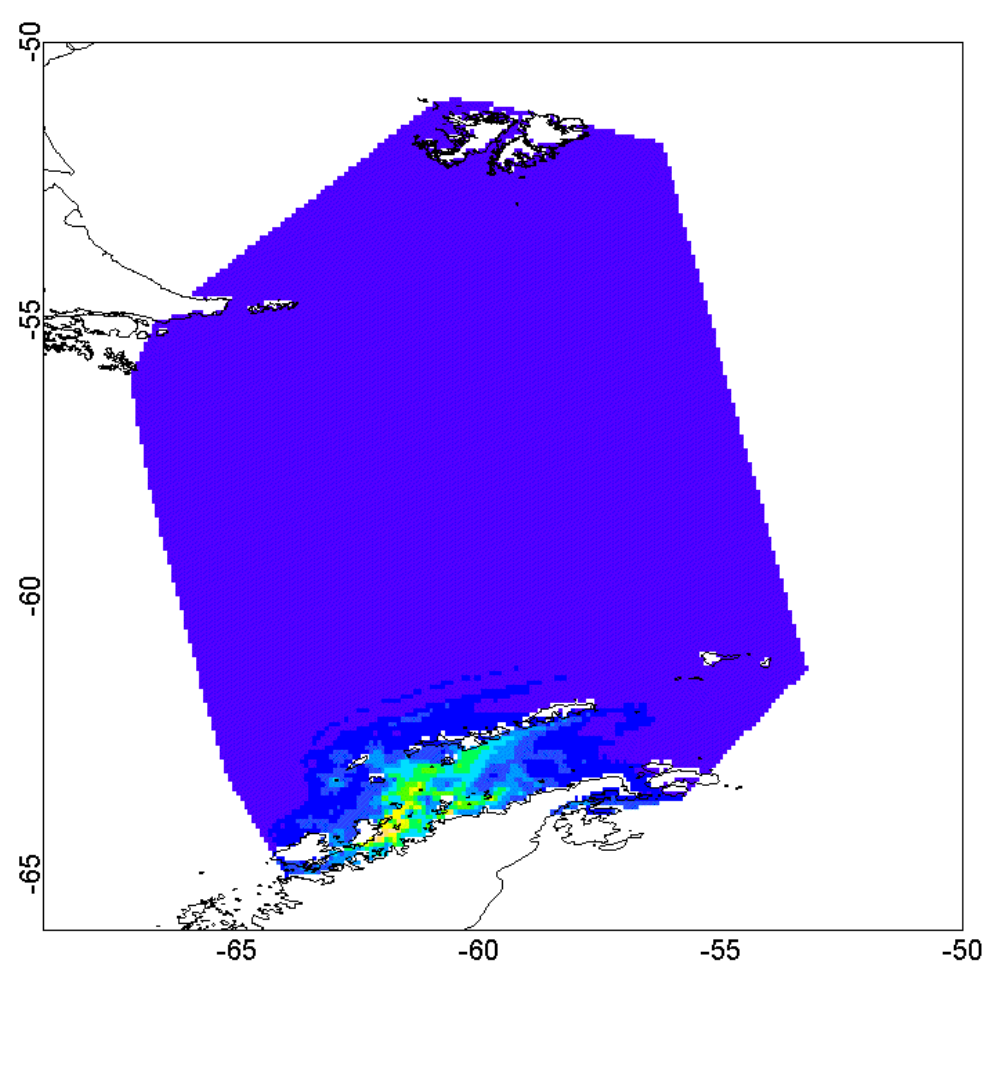
Fig. 3. An animation showing variation in predicted density of humpback whales. Each frame of the animation reflects an iteration of jackknife resampling: the removal of one trip’s effort and sightings data; refitting the detection function on the remaining sightings; reevaluating size-bias corrected estimates of mean school size; refitting the spatial model; and prediction across the grid. White patches within the regions of high density reflect grid squares predicted to have >0.22 humpback whale schools/nm 2 . The longest axis of the prediction grid (from the southern tip of South America to the northern tip of the Antarctic Peninsula) is approximately 500 nm long. Note that, although the scale of the density gradient varies among iterations, the placement of the highest-density area along the western Antarctic Peninsula is